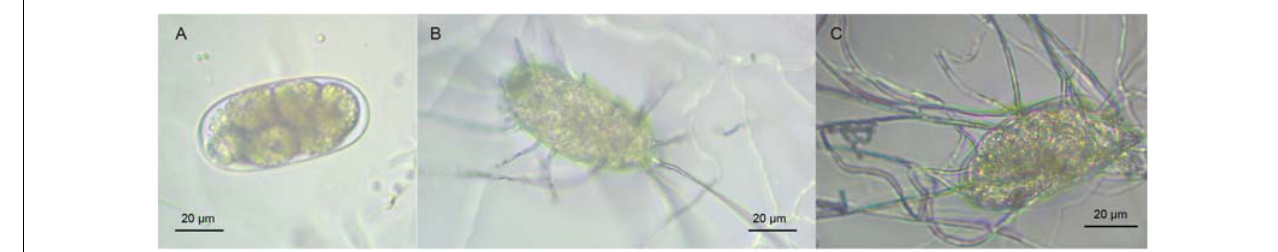
FIGURE 1 | (A) Normal M. incognita eggs. (B,C ) M. incognita eggs infected due to P. lilacinum